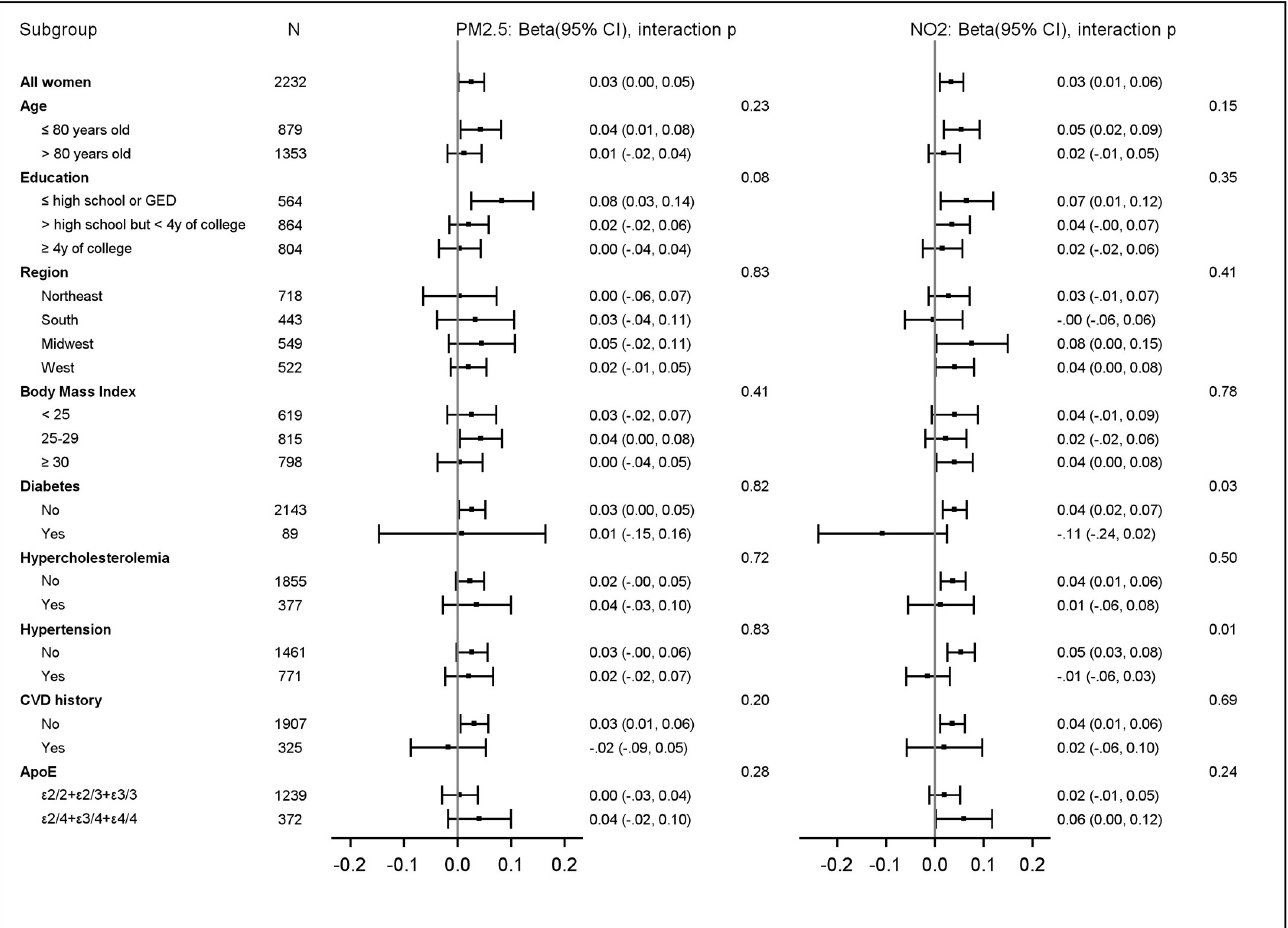
Fig 3. Estimated associations a between AQ improvement b and cognitive ability decline c , stratified by population characteristics. The bars and whisker represent the regression coefficient beta and corresponding 95% CIs. a Association was represented by beta, the regression coefficient estimating the increase in TICSm score per year for each IQR increase of AQ improvement (IQR PM2.5 = 1.79 μ g/m 3 ; IQR NO2 = 3.92 ppb), adjusting for spatial random effect, WHIMS-ECHO enrollment year, age, follow-up year, age interaction with follow-up year, time-varying propensity scores, demographic variables (geographic region and race/ ethnicity), socioeconomic factors (education, income, and employment status) and neighborhood characteristics, lifestyle factors (smoking, drinking, and physical activities), prior hormone use, hormone therapy assignment, cardiovascular risk factors (hypertension, diabetes, and hypercholesterolemia), depression, BMI, and CVD histories. b Recent exposures were the 3-year average exposures estimated at the WHIMS-ECHO enrollment. Remote exposures were the 3-year average exposures estimated 10 years before the WHIMS-ECHO enrollment. AQ improvement was defined by reduction from remote to recent exposures over the 10-year period. c p -Value was calculated using Wald t test for the interaction between AQ improvement and each subgroup unadjusted for multiple comparison. After controlling for multiple comparison using Benjamini–Hochberg approach, false discovery rate corrected p -values > 0.05 for all interaction tests. ApoE, Apolipoprotein E; AQ, air quality; BMI, body mass index; CVD, cardiovascular disease; GED, general educational development; IQR, interquartile range; NO 2 , nitrogen dioxide; PM 2.5 , fine particulate matter; ppb, parts per billion; TICSm, modified Telephone Interview for Cognitive Status; WHIMS-ECHO, Women’s Health Initiative Memory Study-Epidemiology of Cognitive Health